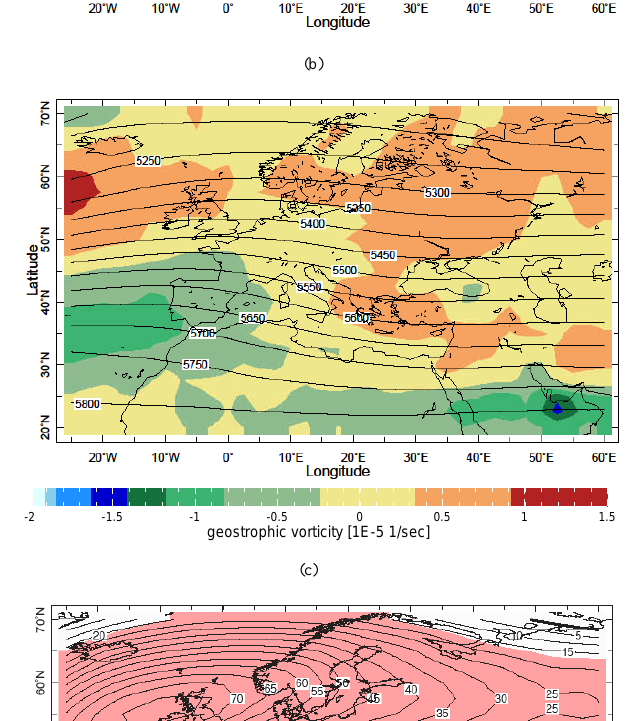
Fig. 7. DJF long-term mean sea level pressure difference (in hPa 797 units) between the simulations and observations for the Northern Hemisphere.